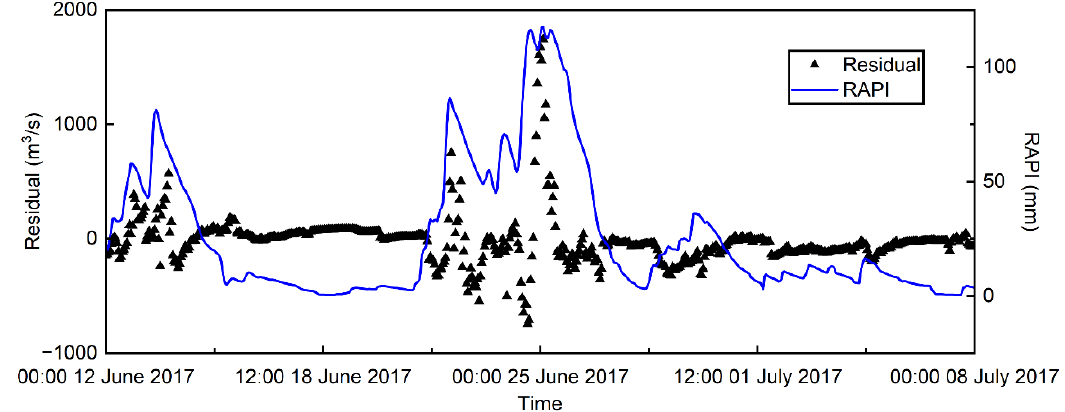
Figure 6. Model residual and RAPI time series of the flood event with the largest peak flow. The optimal RAPI estimates are plotted using the blue solid line, and residuals are plotted using black triangle markers.